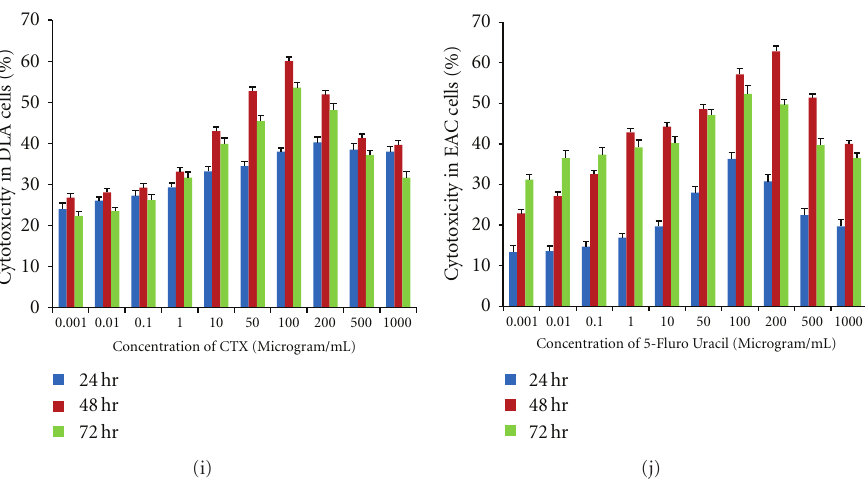
Figure 1: (a–e) Cytotoxicity profile of PST001 on human and murine cancer cell lines as measured by MTT assay: (a) A549 (lung adeno carcinoma), (b) KB (oral cancer), (c) MCF-7 (breast cancer), and (d and e) DLA and EAC (Murine cancer cells). (f–j) Cytotoxicity profile of positive control drugs on human and murine cancer cell lines as measured by MTT assay: (f) A549 (Cisplatin), (g) KB (Doxorubicin), (h) MCF-7 (Doxorubicin), (i) DLA (CTX), and (j) EAC (5-Fluro